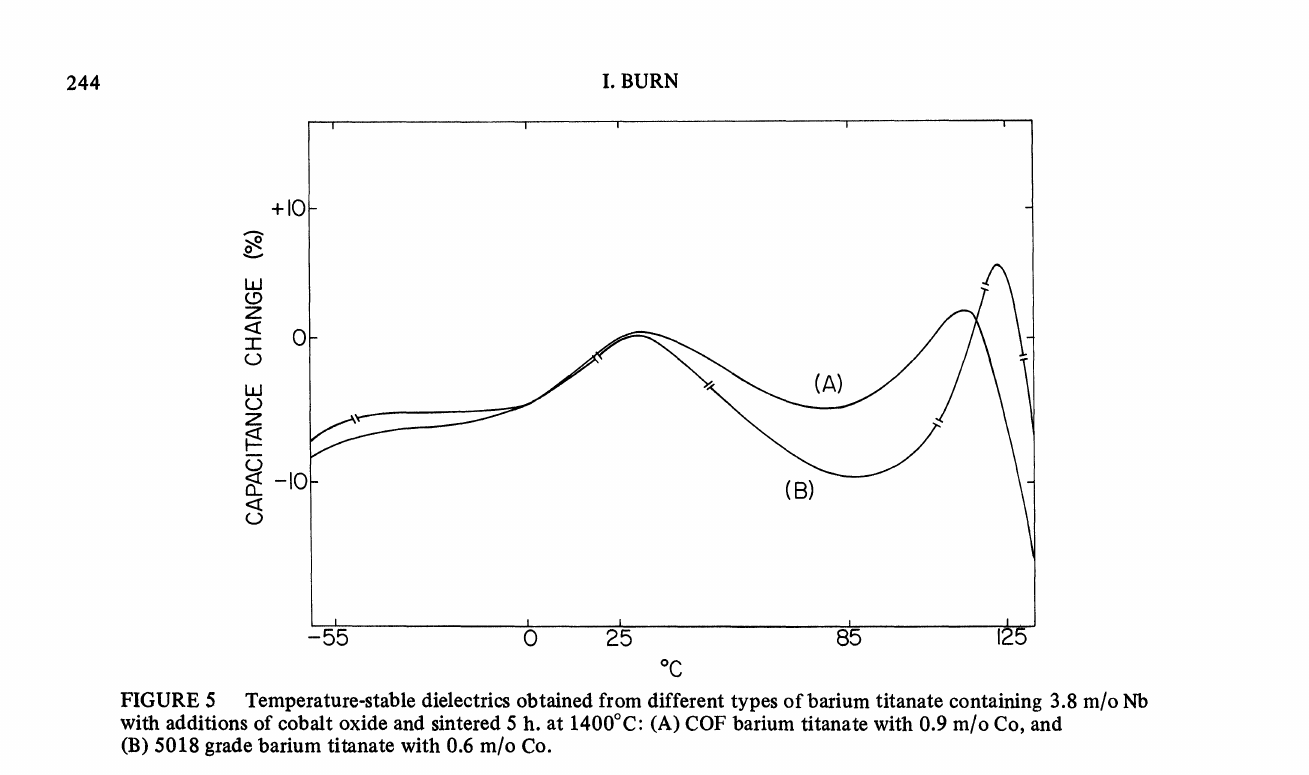
Temperature-stable dielectrics obtained from different types of barium titanate containing 3.8 m/o Nb with additions of cobalt oxide and sintered 5 h. at 1400C: (A) COF barium titanate with 0.9 m/o Co, and (B) 5018 grade barium titanate with 0.6 m/o Co.